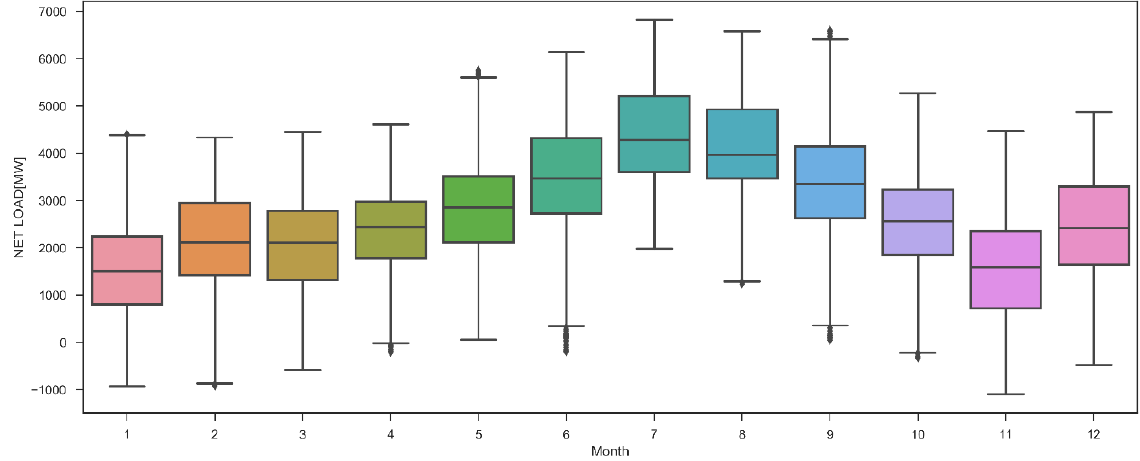
Figure 3. Net load distribution per month in the RTS-GMLC.